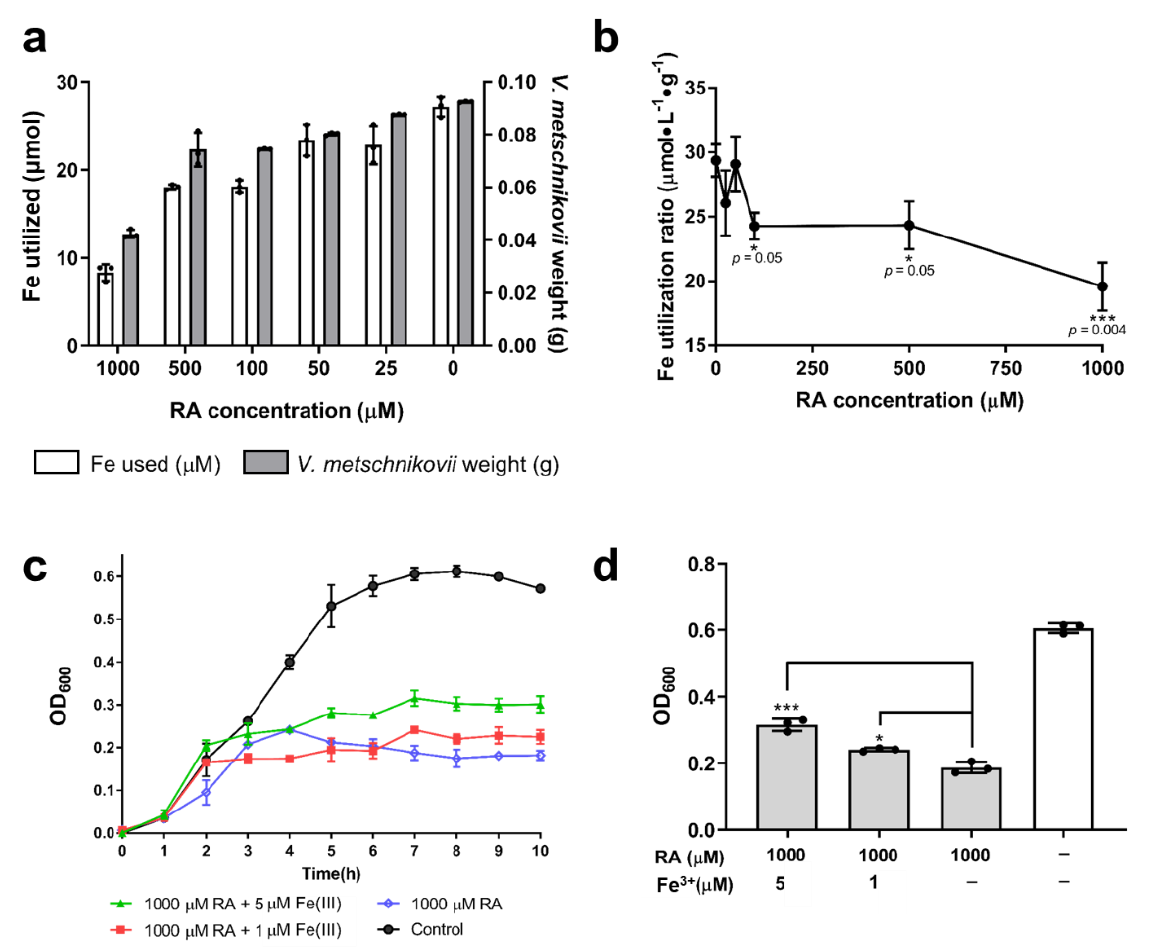
Figure 5. Iron utilization in V. metschnikovii and recovery of V. metschnikovii by adding Fe 3+ . ( a ) Weight and iron utilization of V. metschnikovii after 7 h of culture with RA (0, 25, 50, 100, 500, and 1000 μM). ( b ) Fe utilization ratio of V. metschnikovii after 7 h culture with RA (0, 25, 50, 100, 500, 1000 μM). ( c ) V. metschnikovii growth from 0 to 10 h in the presence of 1000 μM RA with FeCl 3 (10 or 50 μM). ( d ) Growth recovery of V. metschnikovii at 7 h with 1000 μM RA and supplementation of 1 or 5 μM FeCl 3 . * p < 0.05, *** p < 0.001.